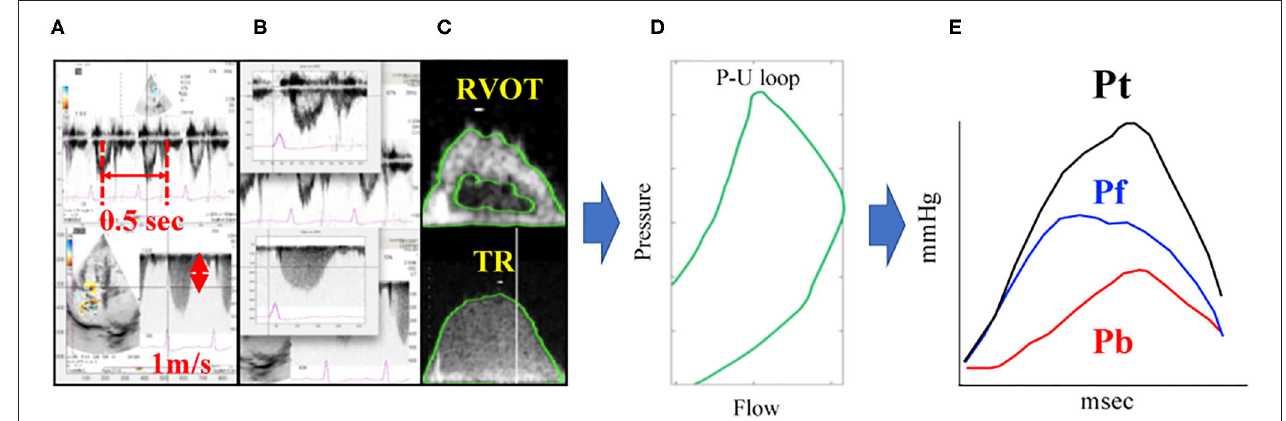
FIGURE 2 | PAWR assessment by Doppler echocardiography. Process of (A–E) were processed using an in-house program code written in MATLAB. (A) , Defining the time axis and flow velocity axis. (B) , Synchronizing TR flow and RVOT flow from the electrocardiogram. (C) , Contour detection of TR flow and RVOT flow. The envelope of the RVOT flow Doppler signal was traced semi-automatically to obtain the U waveform. The P waveform was estimated by applying the simplified Bernoulli equation to a semi-automatic tracing of the envelope of the TR Doppler signal. These waveforms were smoothened using a Savitzky–Golay filter and then ensemble-averaged over three cardiac cycles with reference to the R wave on the electrocardiogram. (D) , Determination of the P-U loop. (E) , PAWR indices gained by wave separation analysis. This sample dog is same dog in Figure 1 . TR, tricuspid regurgitation; RVOT, right ventricular outflow tract; PAWR, pulmonary arterial wave reflection; Pt, total pressure; Pf, forward pressure; Pb, backward